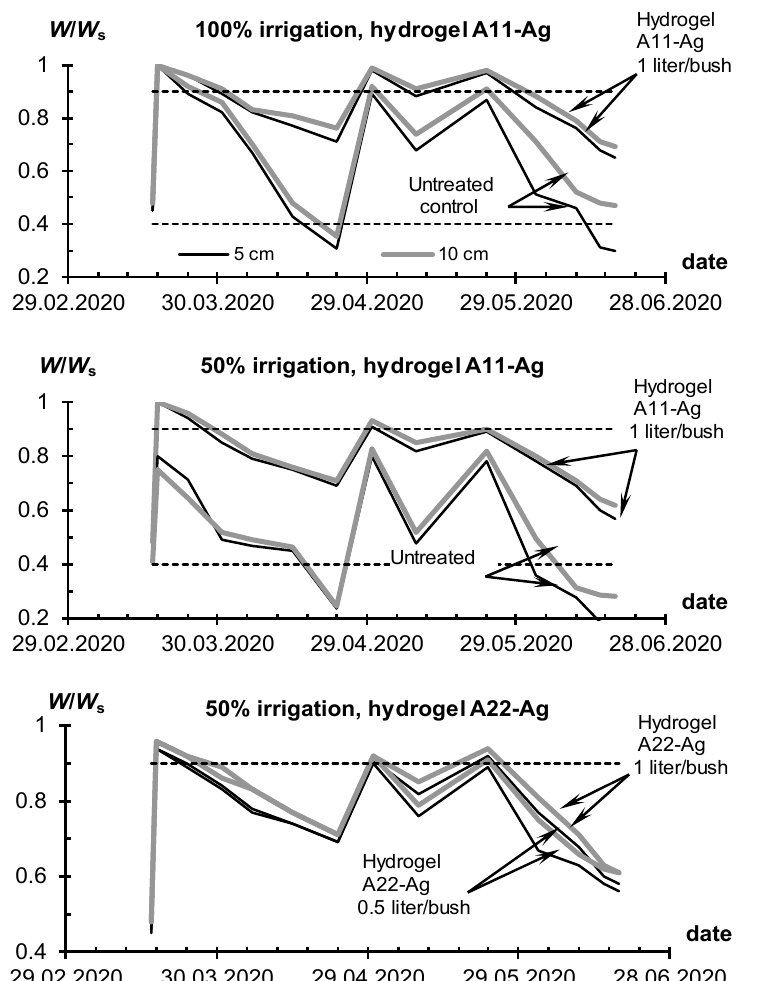
Figure 10. Soil water–air regime under the influence of irrigation and gel-forming conditioners (Uzbekistan, Serozem, furrow irrigation, 2020). The dotted lines are the critical limits of the optimal values for the W/W s index (see Figure 9).